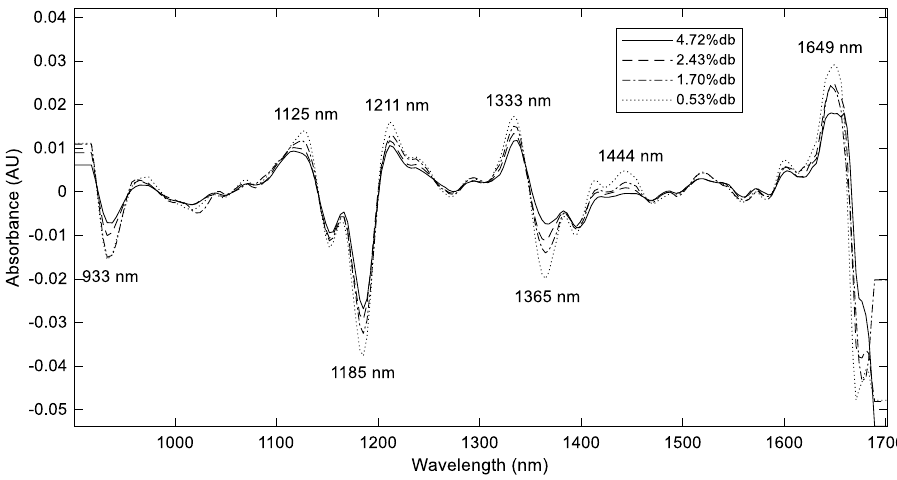
Fig. 6. Mean spectra of rubber sheets with di®erent moisture contents preprocessed by the second derivative.